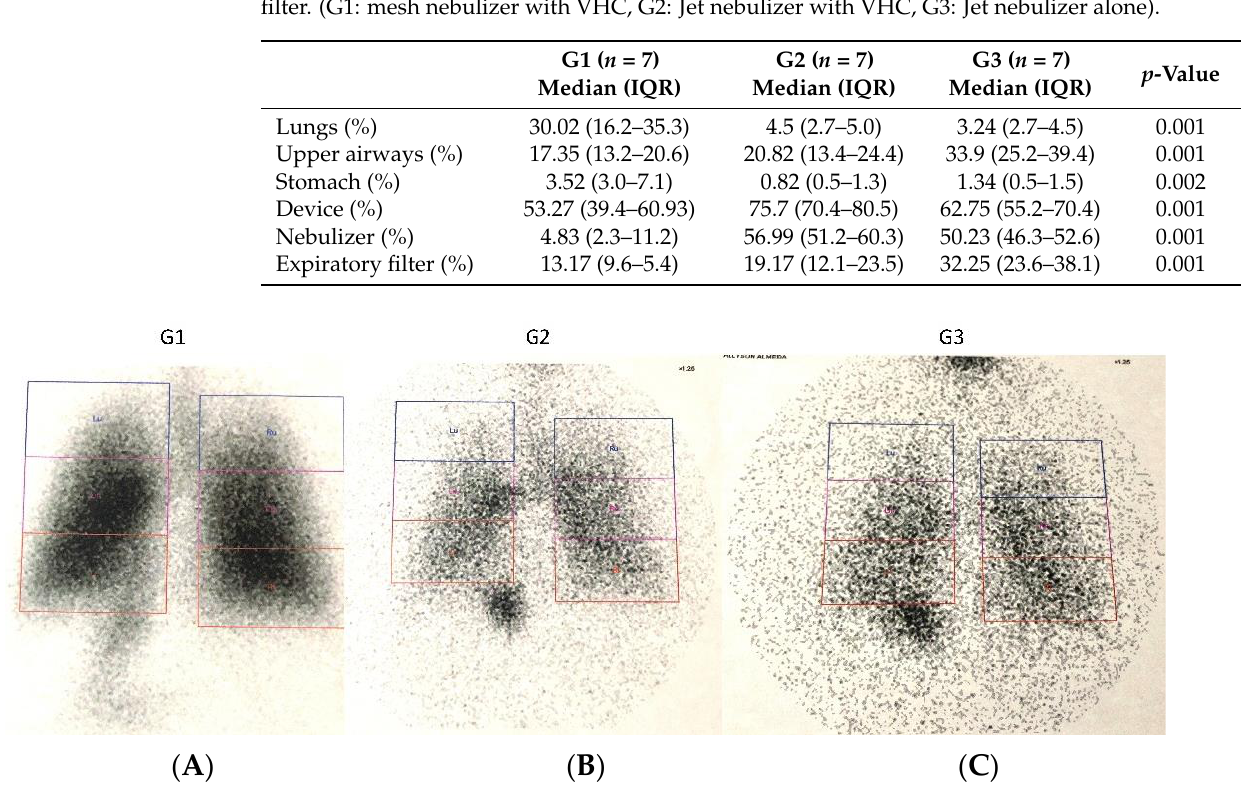
Figure 4. Representative images of posterior thorax post-nebulization with each device configuration. ( A ) G1: Mesh nebulizer with VHC, ( B ) G2: Jet nebulizer with VHC, ( C ) G3: Jet nebulizer alone (Jet nebulizer without VHC).